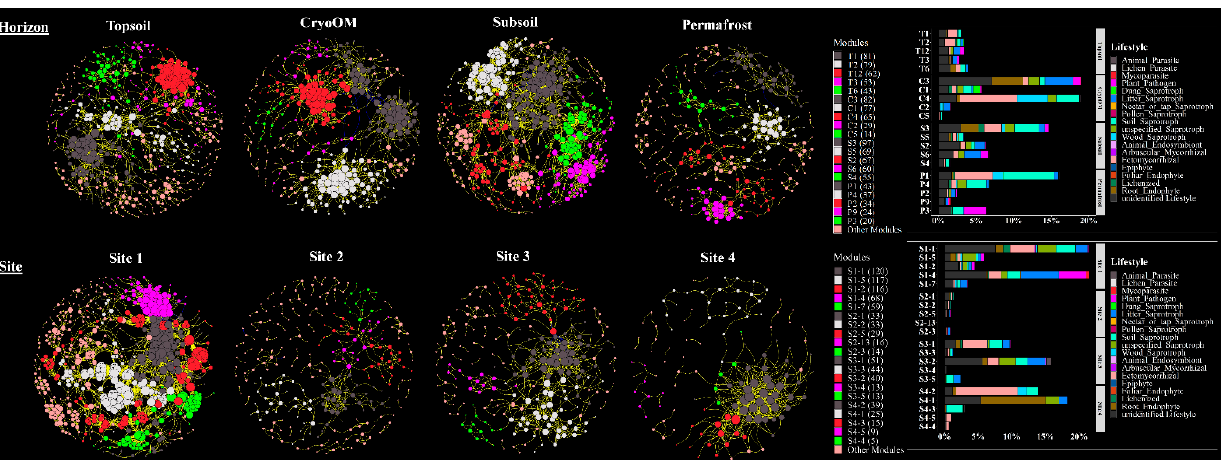
Figure 3. Co-occurrence network interaction of fungal zOTUs found in each horizon and tundra site. A connection stands for a strong Spearman’s correlation ( r ≥ 0.6 and p -value ≤ 0.01). Each circle or node represented a fungal zOTU and the sizes of the circles were proportional to the values of node square-root degree. Lines connecting two fungal zOTU represented the interactions between them, yellow and blue lines represented the positive and negative significant correlations, respectively. Nodes were colored according to the top five modules. The relative proportion of fungal lifestyle from the top five modules of each horizon and tundra site are shown.